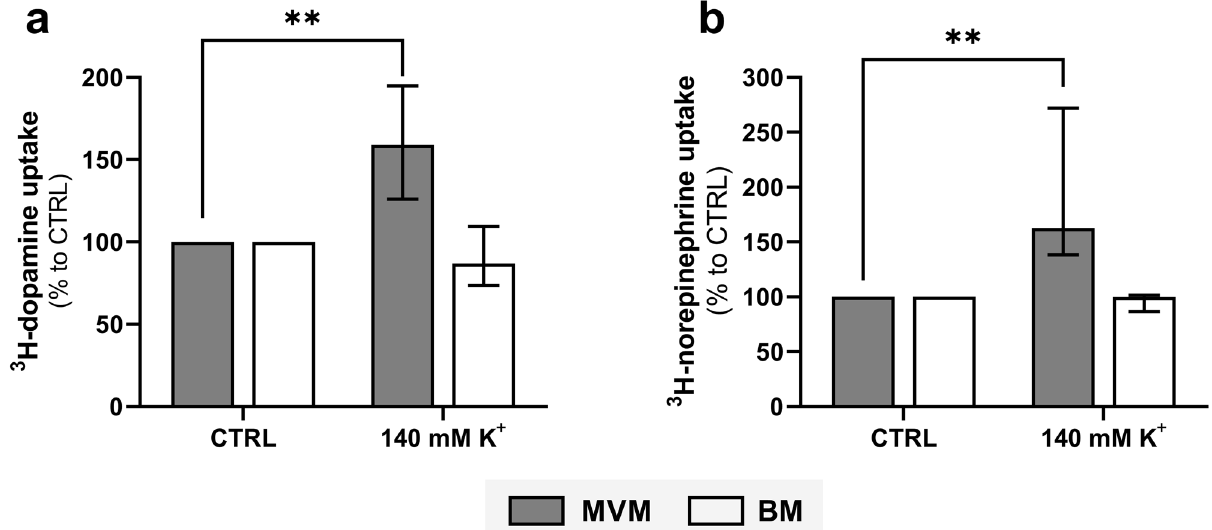
Figure 3. The effect of intracellular K + on monoamine uptake systems in MVM and BM vesicles isolated from human term placenta. Uptake of 3 H-dopamine ( a ) and 3 H-norepinephrine ( b ) was determined in membrane vesicles preloaded overnight with 140 mM K + . Results are presented as percent uptake relative to the unloaded vesicles (CTRL). Data are expressed as median with interquartile range, n = 4. Statistical analyses were performed using Mann–Whitney test: **( p ≤